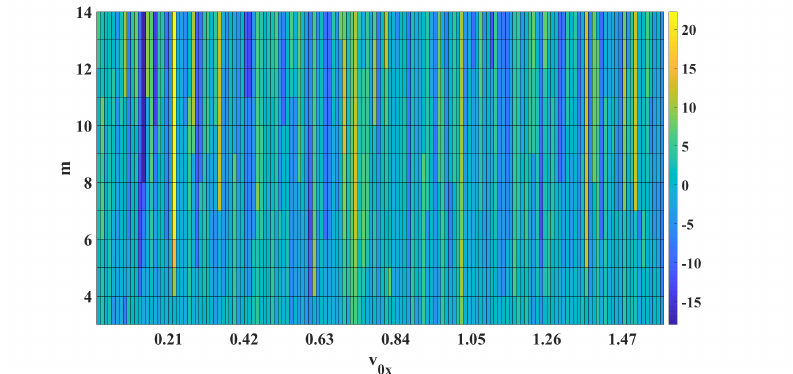
Figure 14. Basin of attraction of settling locations for v 0 x with changes in m .